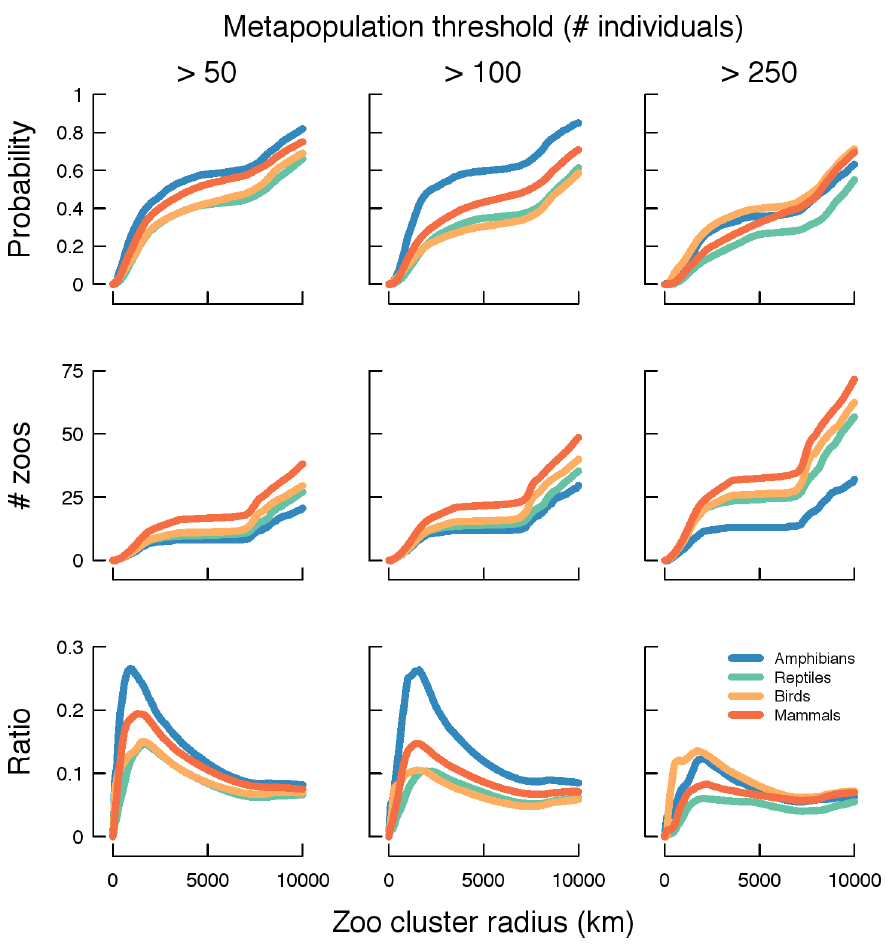
Figure 3. Average probability of finding a metapopulation size above 50, 100 or 250 individuals as a function of the length of the zoo cluster radial distance (upper row), average number of zoos where the species is found as a function of the radial distance (middle row) and ratio between the probability of finding the metapopulation and the radial distance (lower row) for each taxonomic class of terrestrial vertebrates. When the ratio is highest, we obtain the optimal radial distance between zoos and the optimal probability of finding a metapopulation size above the threshold. This is, at that ratio the probability of finding the metapopulation is highest with respect to the zoo cluster radial distance. For display purposes all ratios were multiplied by 1,000.